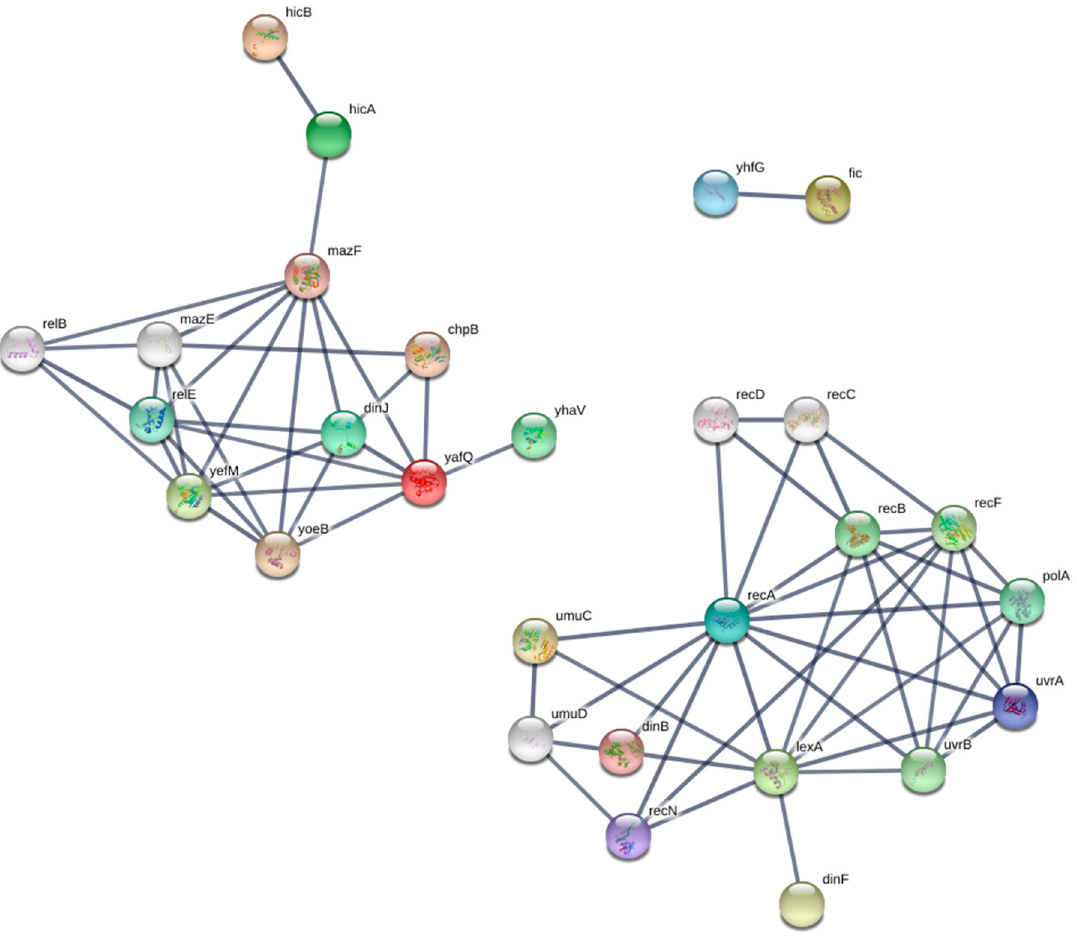
Figure 5. Protein–protein interaction (PPI) network. Each node represents a given protein, and the edges represent the degree of association between the given nodes. The network is divided into 3 independent clusters; the top-left cluster shows the PPIs between the interactors with yafQ-hicA-hicB as the seed/query nodes. The bottom-right cluster shows the PPIs between the interactors with lexA as the seed/query node. The top-right cluster shows a single interaction involving fic as the seed node.